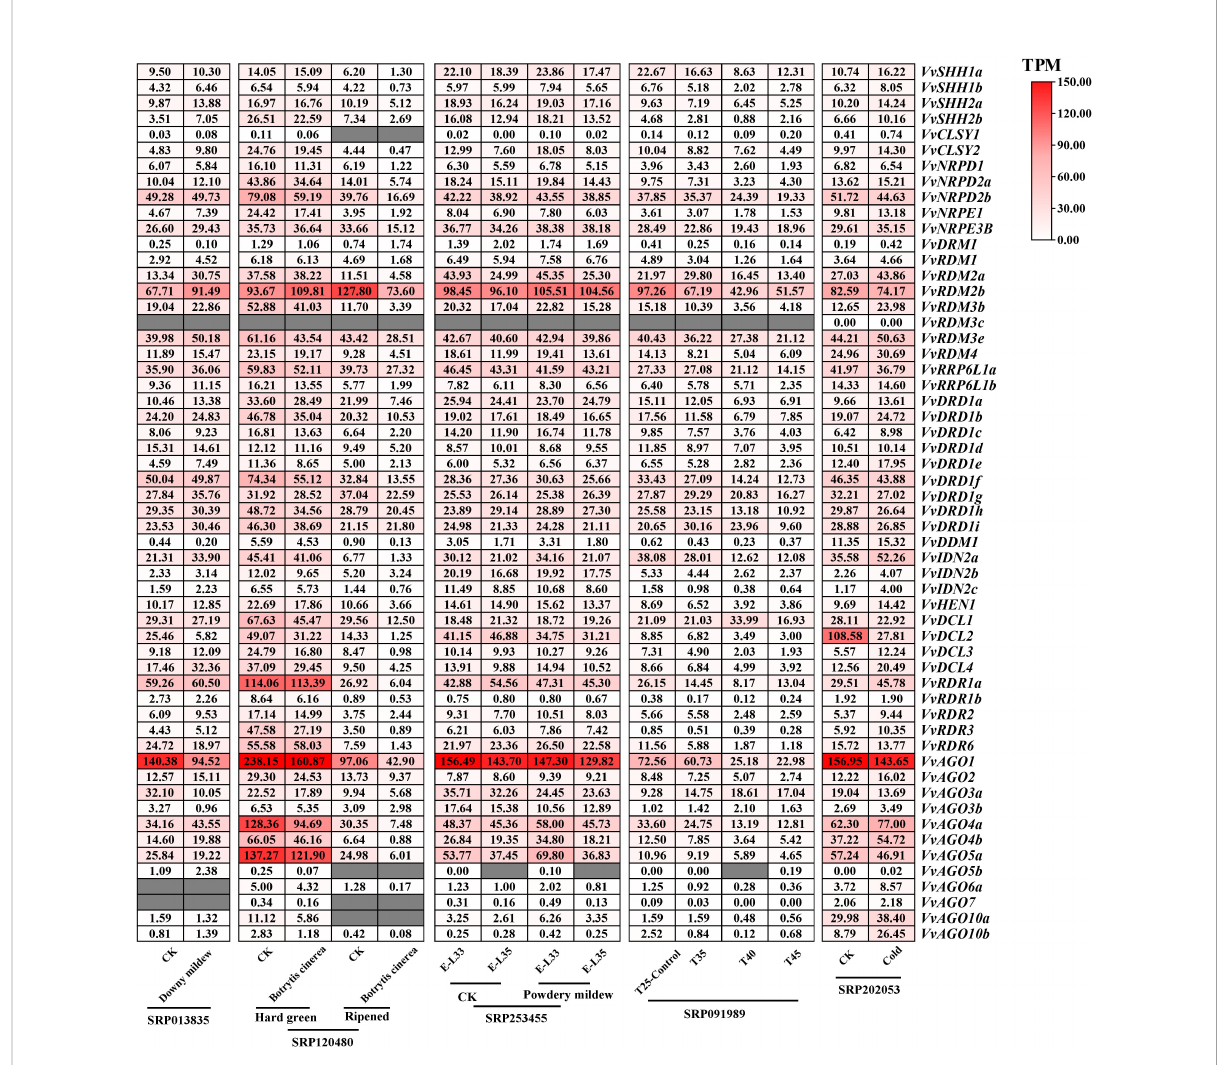
FIGURE 7 Transcriptomic expression of VvRdDM genes following biotic and abiotic stresses. Transcriptome data were downloaded from the NCBI SRA datasets (SRP013835, SRP120480, SRP253455, SRP091989 and SRP202053). For transcriptomic analysis plant samples following different stress were collected; For downy mildew infected leaves; Botrytis cinerea infected fruits at 2 stages (hard green and ripened stage); Powdery mildew treated fruits at 2 growth stages (EL33 and EL35). For high temperature stress, plants grown at 25°C were taken as control, and 35°C, 40°C, and 45°C were the treatments. Low temperature treatment is 4°C, plants grown at 25°C were taken as control. The white and red color scale denotes low and high expression levels, respectively. No gene expression is denoted with grey color. Numbers denote TPM of VvRdDMs